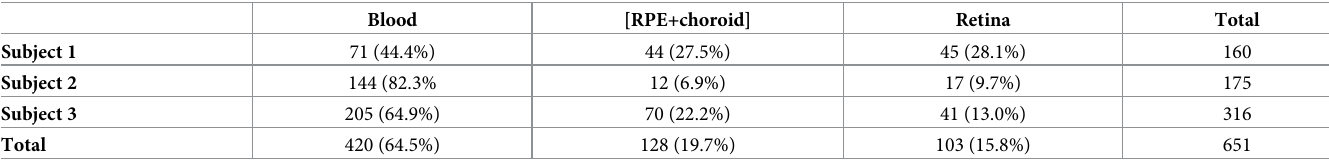
Table 2. Total numbers of SNPs: Combining haplogroup defining SNPs, private SNPs, unique SNPs and heteroplasmy